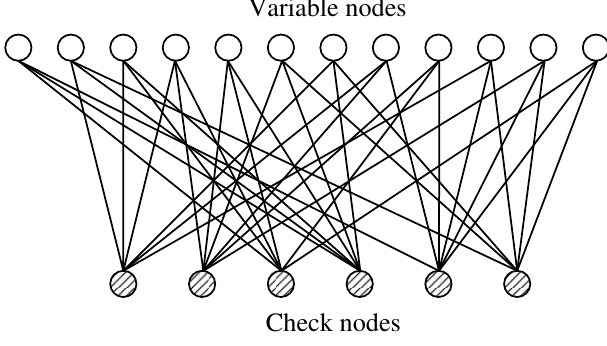
Figure 3. Bipartite graph corresponding to a regular parity check matrix. Variable nodes